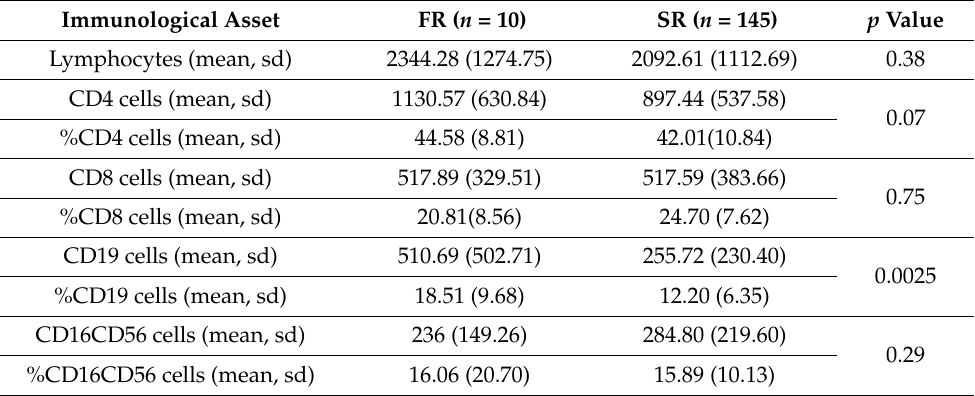
Table 5. Comparison of total lymphocytes and lymphocyte subsets at baseline between patients with fast and slow repopulation rate at twelve months. Data are reported using mean ± standard deviation